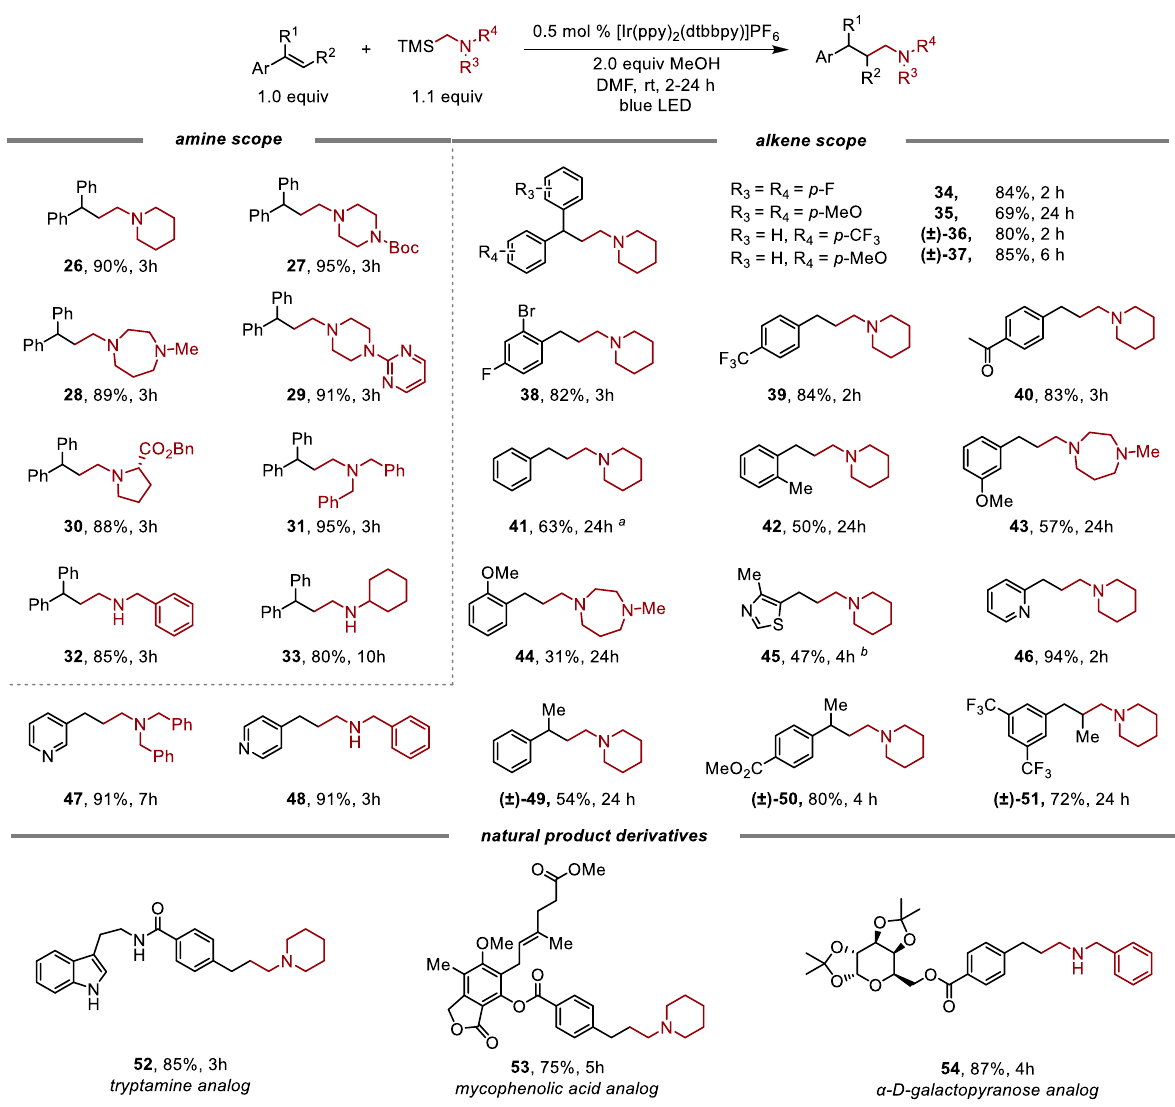
Fig. 4 Scope of hydroaminomethylation with α -TMS amine. Standard conditions (Conditions D) are alkene (0.2 mmol, 1.0 equiv), amine (1.1 equiv), [Ir(ppy) 2 (dtbbpy)]PF 6 (0.5 mol%), DMF (1.0 mL, 0.1 M), r.t., 24 W blue LED light; isolated yields, average of two runs. a The 2.0 equiv amine used. b 1.0 equiv amine and 2.0 equiv alkene